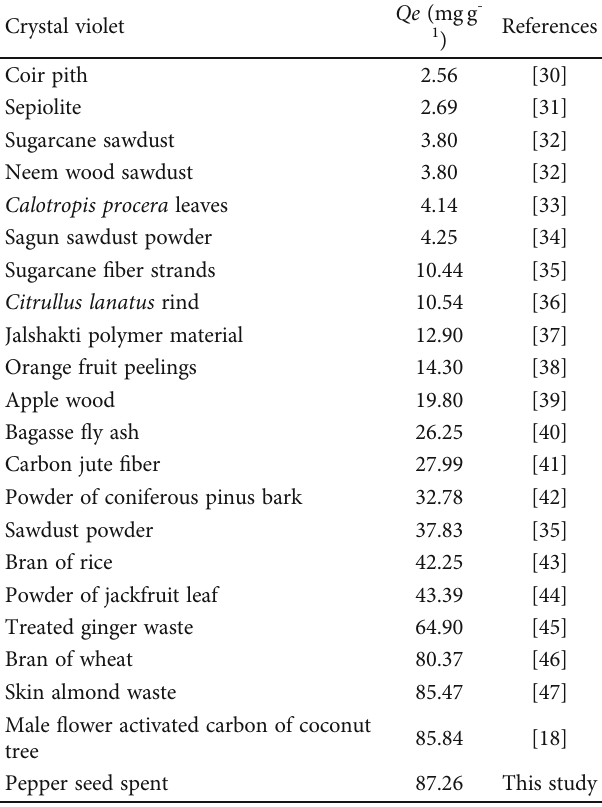
Table 1: The adsorption capacity of di ff erent materials derived from agricultural biomass.